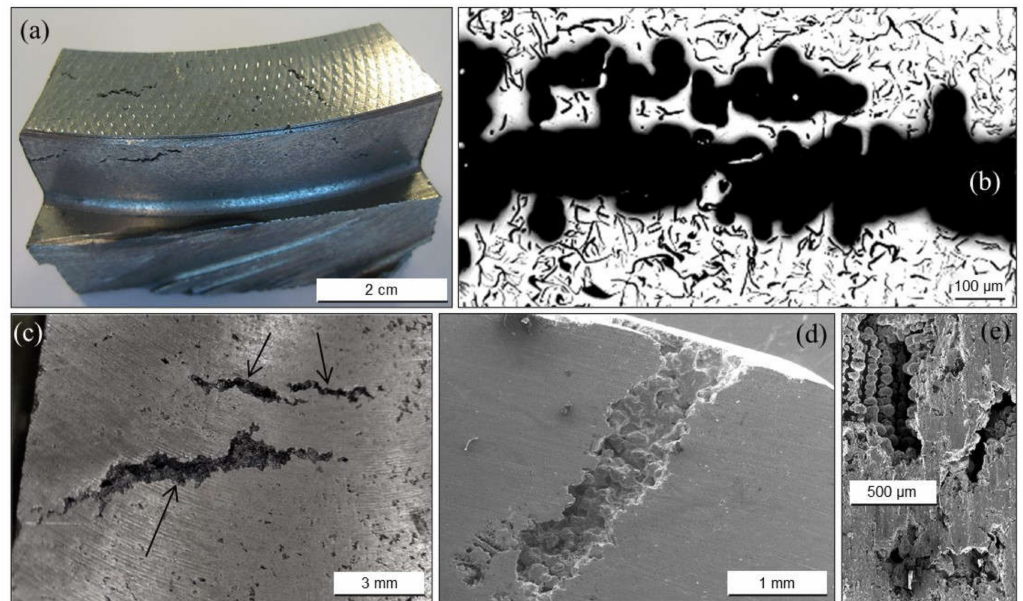
Figure 11. Fissures provoked by the precipitation of nitrogen gas during solidification: ( a , c ) fissures found after machining steps; ( b ) metallographic view of a defect present in a gray iron casting; ( d , e ) SEM views showing dendritic morphologies in the internal surfaces of the